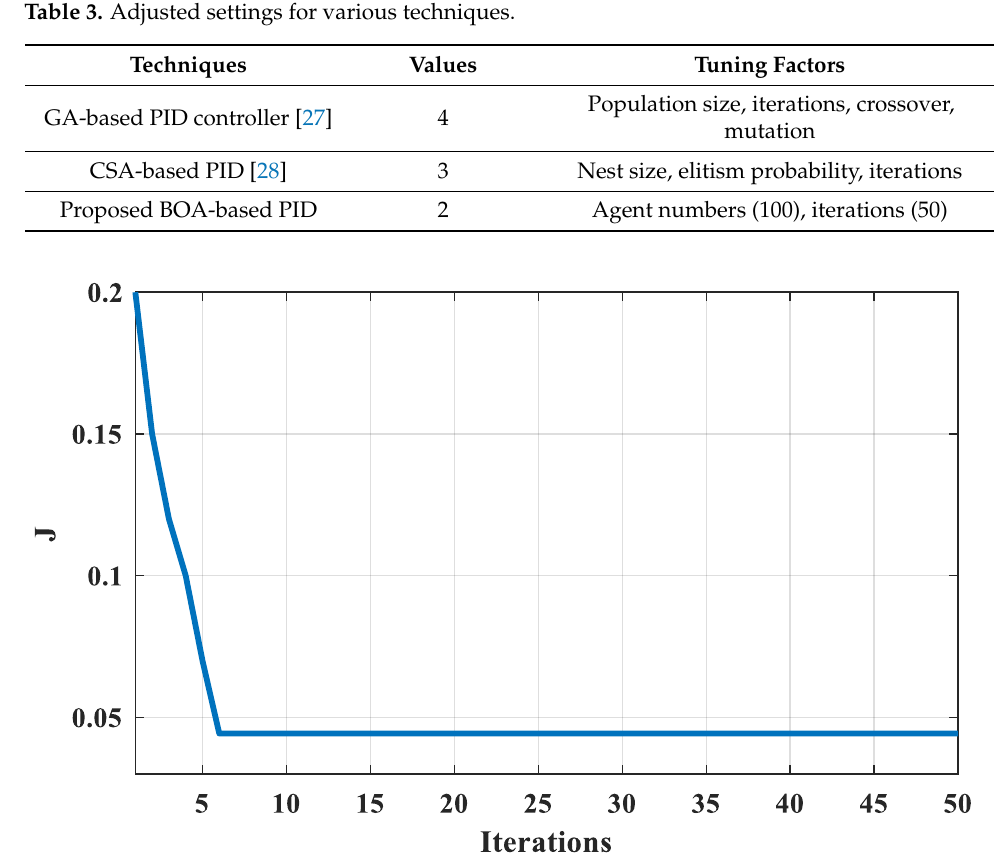
Figure 4. The convergence curve of the proposed BOA.